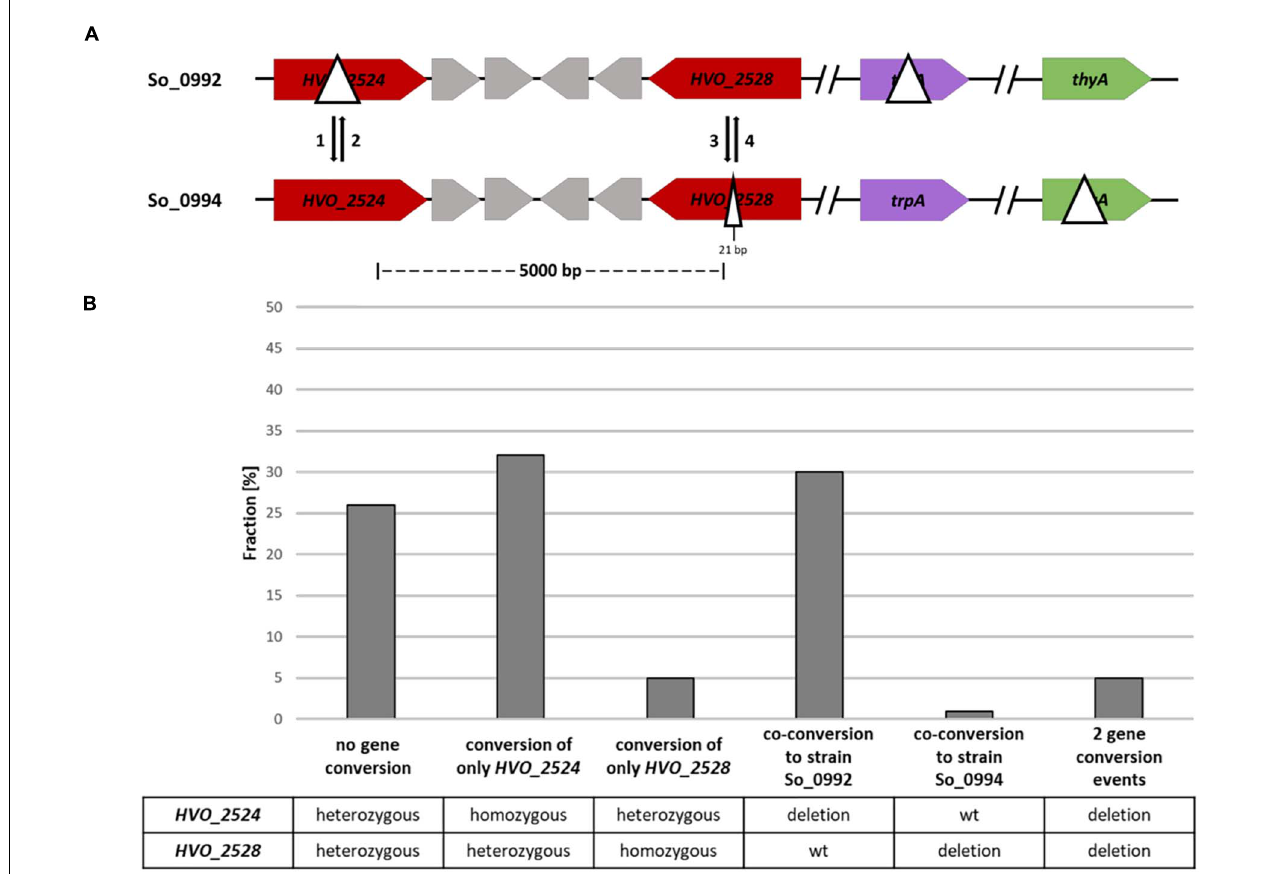
FIGURE 5 | A gene conversion experiment including two different sites with a distance of 5,000 bp. (A) Design of the experiment. The sizes of the internal deletions and the genomic distance between them are indicated. The numbers 1–4 indicate the possible gene conversion events. (B) Results of the experiment. Ninety three randomly chosen white clones were analyzed by PCR with primers that were specific for the two possible gene conversion sites. The fractions (%) of clones are shown that exhibited gene conversion at none, one or two of the sites. One biological replicate was